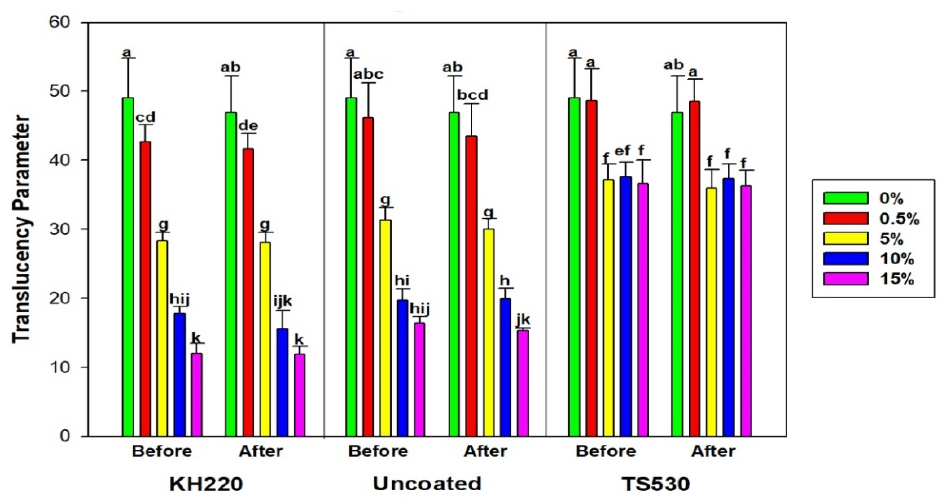
Figure 14. Bar graph displaying means and error bars representing standard error of Translucency Parameter for Indoor samples before and after 3000 h of storage. Lower case letters denote statistical groupings. Groups with means having the same lower-case letters are not significantly different ( p > 0.05, ANOVA/Tukey). Comparisons are both within and across materials.